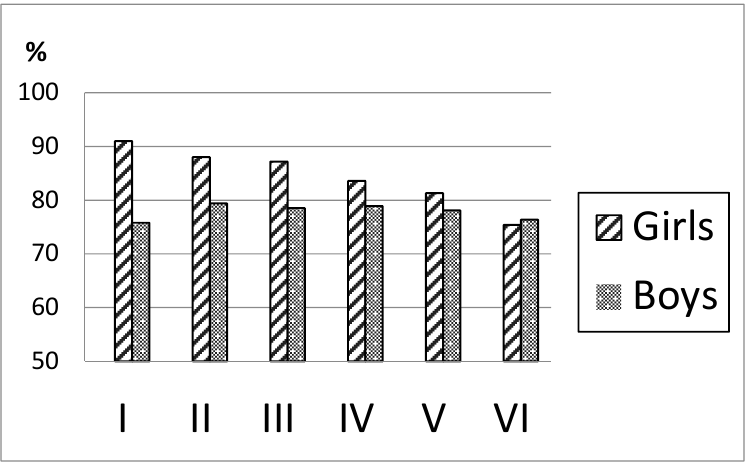
Figure 2. Proportion of girls and boys with a signed smoke-free contract in OSC I-VI.